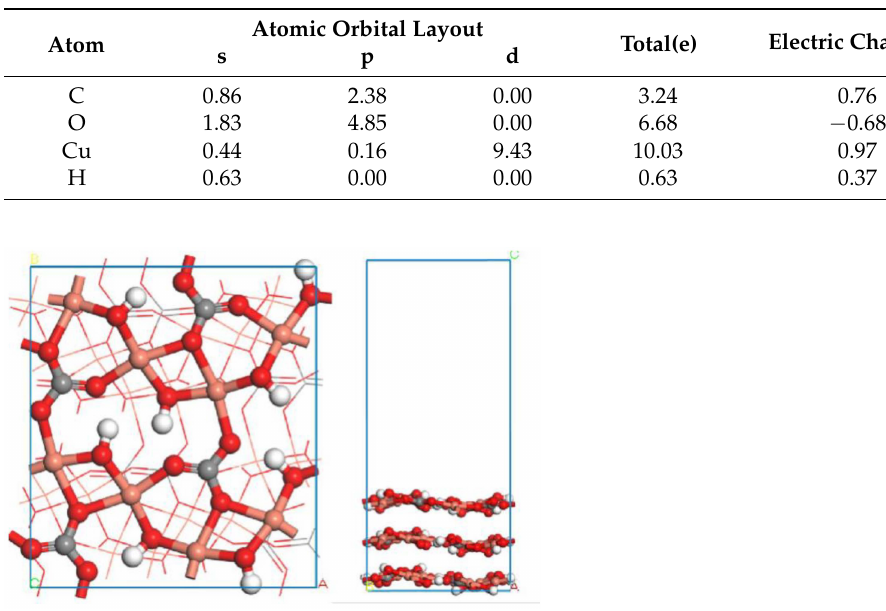
Figure 8. Malachite unit cell of the optimized structural model: ( a ) top view; ( b ) lateral view. Table 2. Mulliken populations of various atoms on malachite’s surface.